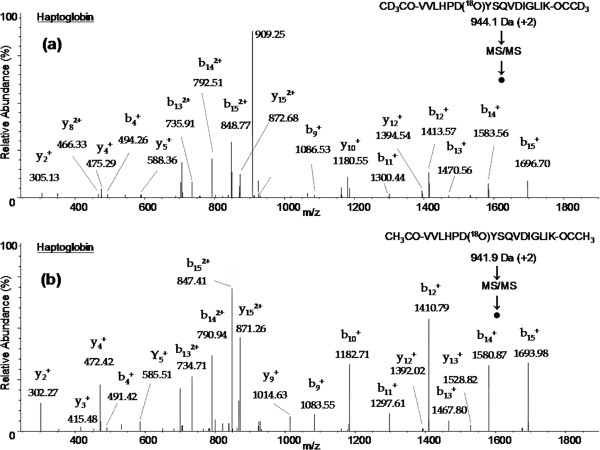
Tandem mass spectra of doubly charged ions of heavy CD3CO- VVLHPD(18O)YSQVDIGLIK- COCD3and CH3CO- VVLHPD(18O)YSQVDIGLIK- OCCH3peptides as identified by LTL quantitative proteomics in normal and ovarian cancer sera analysis.